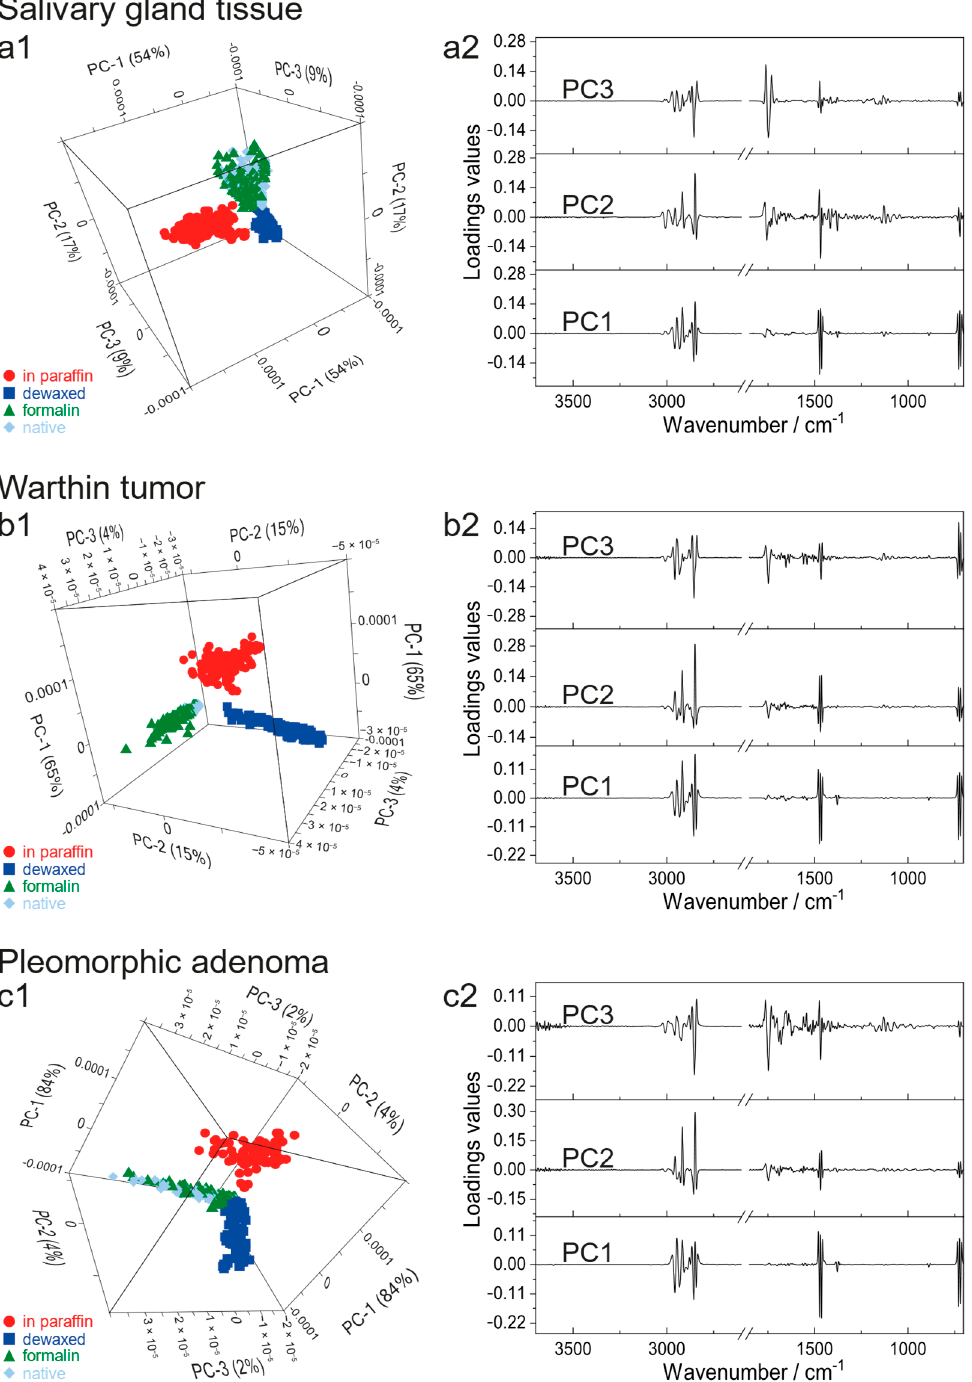
Figure 5. PCA models for the salivary gland tissue ( a ), Warthin’s tumor ( b ) and pleomorphic adenoma ( c ) in terms of the different preservation procedures (“native” (light blue), “formalin” (green), “in paraffin” (red), “dewaxed” (blue)). ( a1 , b1 , c1 ) represent the 3D scores plots, whereas ( a2 , b2 , c2 ) show the corresponding loadings.